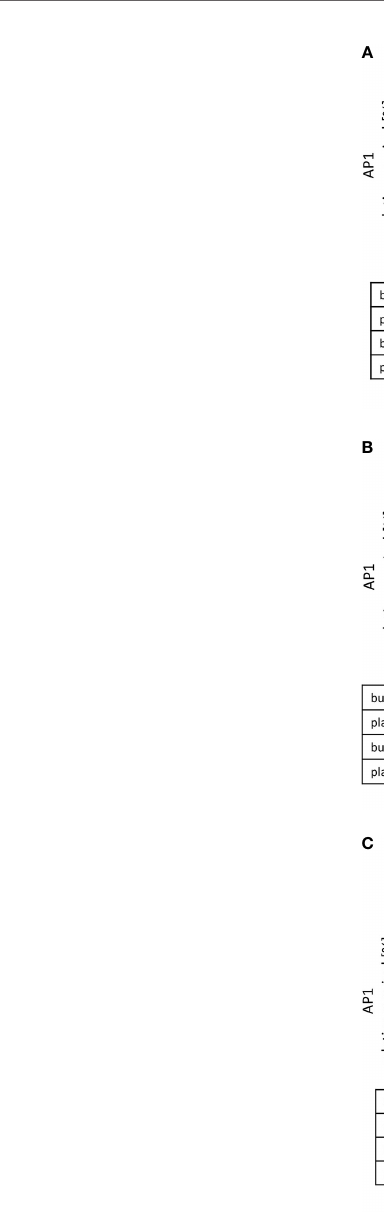
FIGURE 5 | (A) The effect of tetracycline and cold atmospheric plasma on S. pyogenes bacteria covered in a plasma protein layer. S. pyogenes AP1 bacteria were grown to the exponential phase and incubated with 5% human plasma or buffer. The bacteria were then incubated with tetracycline or in CAP-treated buffer for 30min and 60min to assay buffer. The graph represents the relative survival rate, calculated based on the platings for the 30min and 60min time points divided through the starting CFU before the plasma and buffer incubation. CFU counts were measured from 10 -4 dilutions on THY agar plates. The graphs display mean and standard error for the 30min and 60min timepoint. Signi fi cance was calculated using Prism (8.3.0) performing one-way ANOVA (Tukey ’ s multiple comparisons test) based on technical quadruplicates per individual biological sample with performing the assay three times independently. *** p ≤ 0.001, ns p=not signi fi cant. Survival of S. pyogenes bacteria upon combined treatment with CAP and LL-37 or CAP and tetracycline. S. pyogenes AP1 bacteria were grown to the exponential phase and incubated with 5% human plasma or buffer. The bacteria were then subjected to CAP-treated buffer and added for 30min and 60min to a buffer containing LL-37 (B) or tetracycline (C) . The graph represents the relative survival rate, calculated based on the platings for the 30min and 60min time points divided through the starting CFU before the plasma and buffer incubation. CFU counts were measured from 10 -4 dilutions on THY agar plates. The graphs display mean and standard error for the 30min and 60min time point. Signi fi cance was calculated using Prism (8.3.0) performing a one-way ANOVA (Tukey ’ s multiple comparisons test) based on technical quadruplicates per individual biological sample with performing the assay three times independently. *p ≤ 0.033, **p ≤ 0.01, ***p ≤ 0.001, ns p=not signi fi